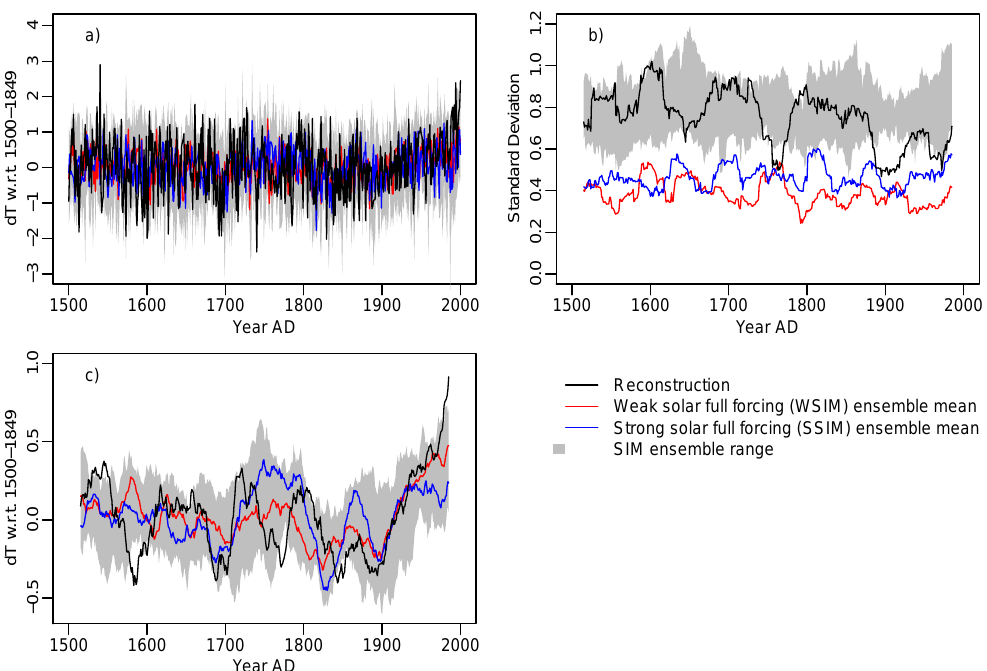
Fig. 1. (a) Time series, (b) moving 31yr standard deviations and (c) moving 31yr means for the Central European annual temperature data. Black is the target data and transparent light grey shading is the range of the ensemble. Red (blue) lines are for the WSIM (SSIM) full-forcing simulation ensemble